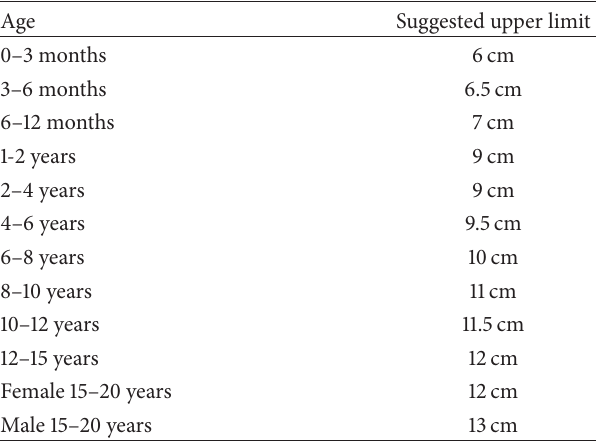
Table 1: Age and suggested upper limit of the length of the spleen, according to Rosenberg’s study